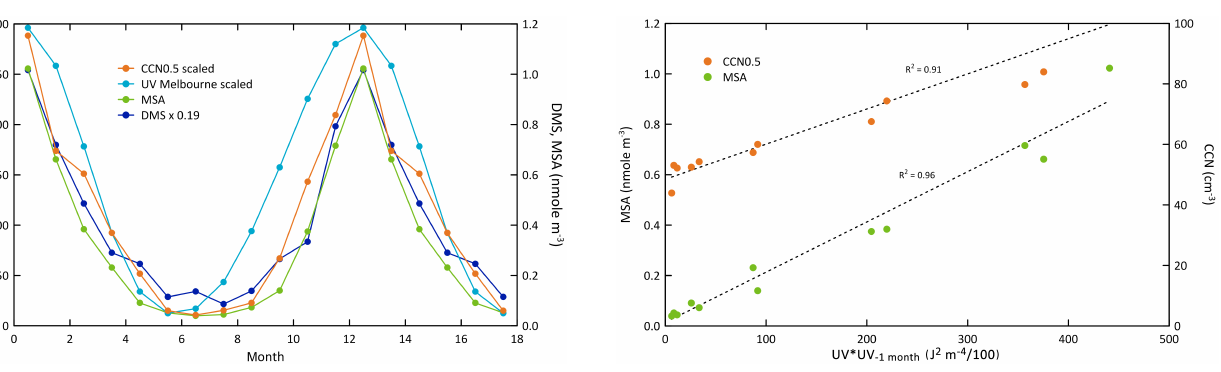
Figure 8. CCN and MSA (CCN median, 1981–2006 (scaled); MSA median, 1985–2007; UV Melbourne, 1976–2008).